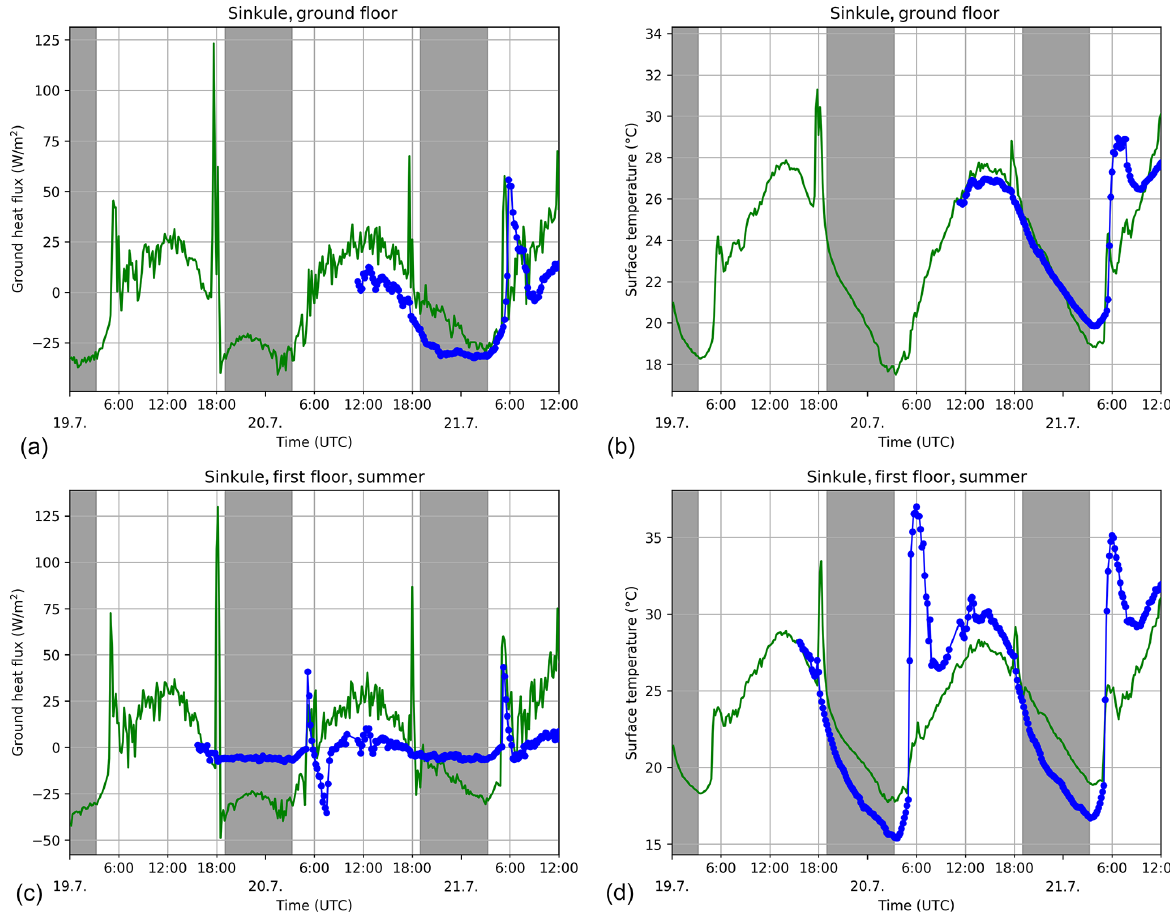
Figure 24. Modelled (green) and observed (blue) wall heat flux (a, c) and surface temperature (b, d) for 19–21 July 2018 for the ground floor wall (a, b) and for the first floor wall (c, d) at the Sinkule house location. The grey areas denote